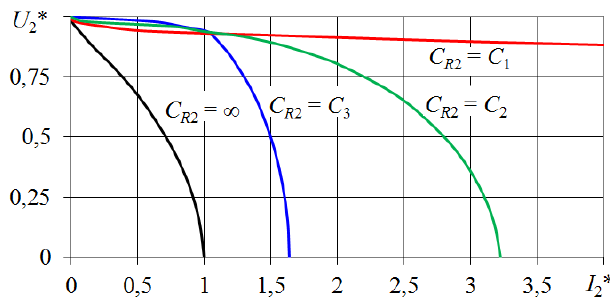
Figure 6. External characteristics of the power transmission system for different values of the resonant capacitor C in the load circuit: Р = C > C > C С R2 1 2 3